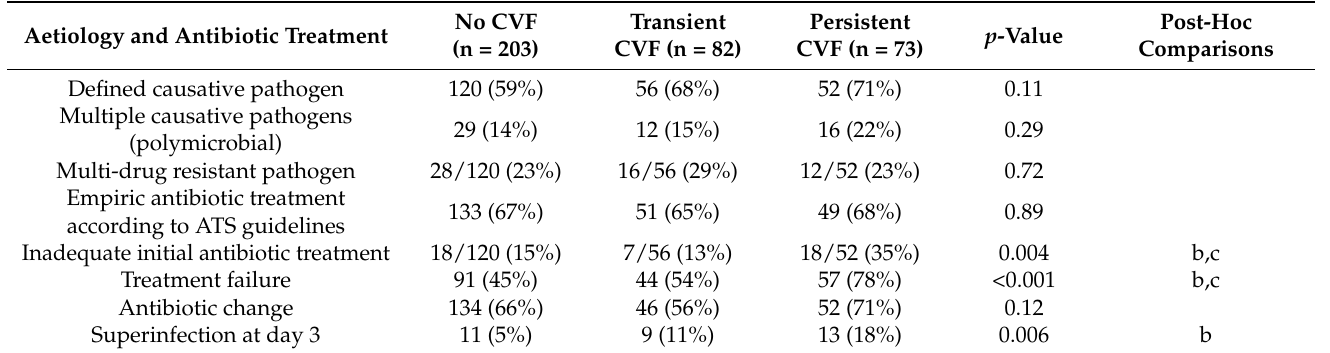
Table 5. Aetiology and antibiotic treatment.